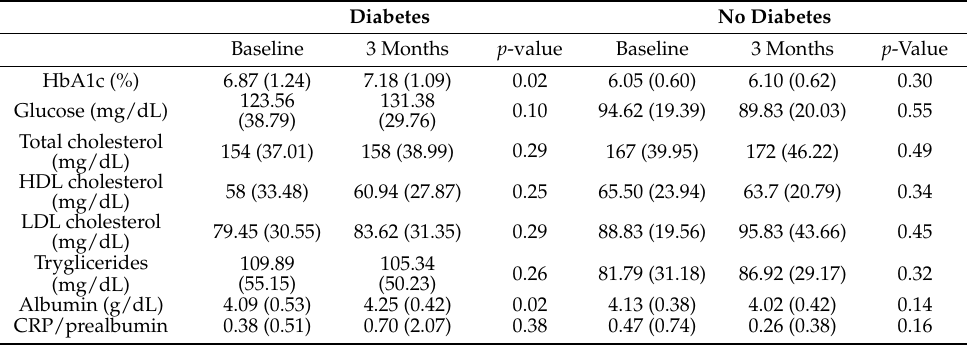
Table 7. Difference in the metabolic parameters before and 3 months after the start of the nutritional intervention based on the diagnosis of diabetes (DIABETES) or alterations in the carbohydrate’s metabolism (NO DIABETES). Diabetes No Diabetes Baseline 3 Months p